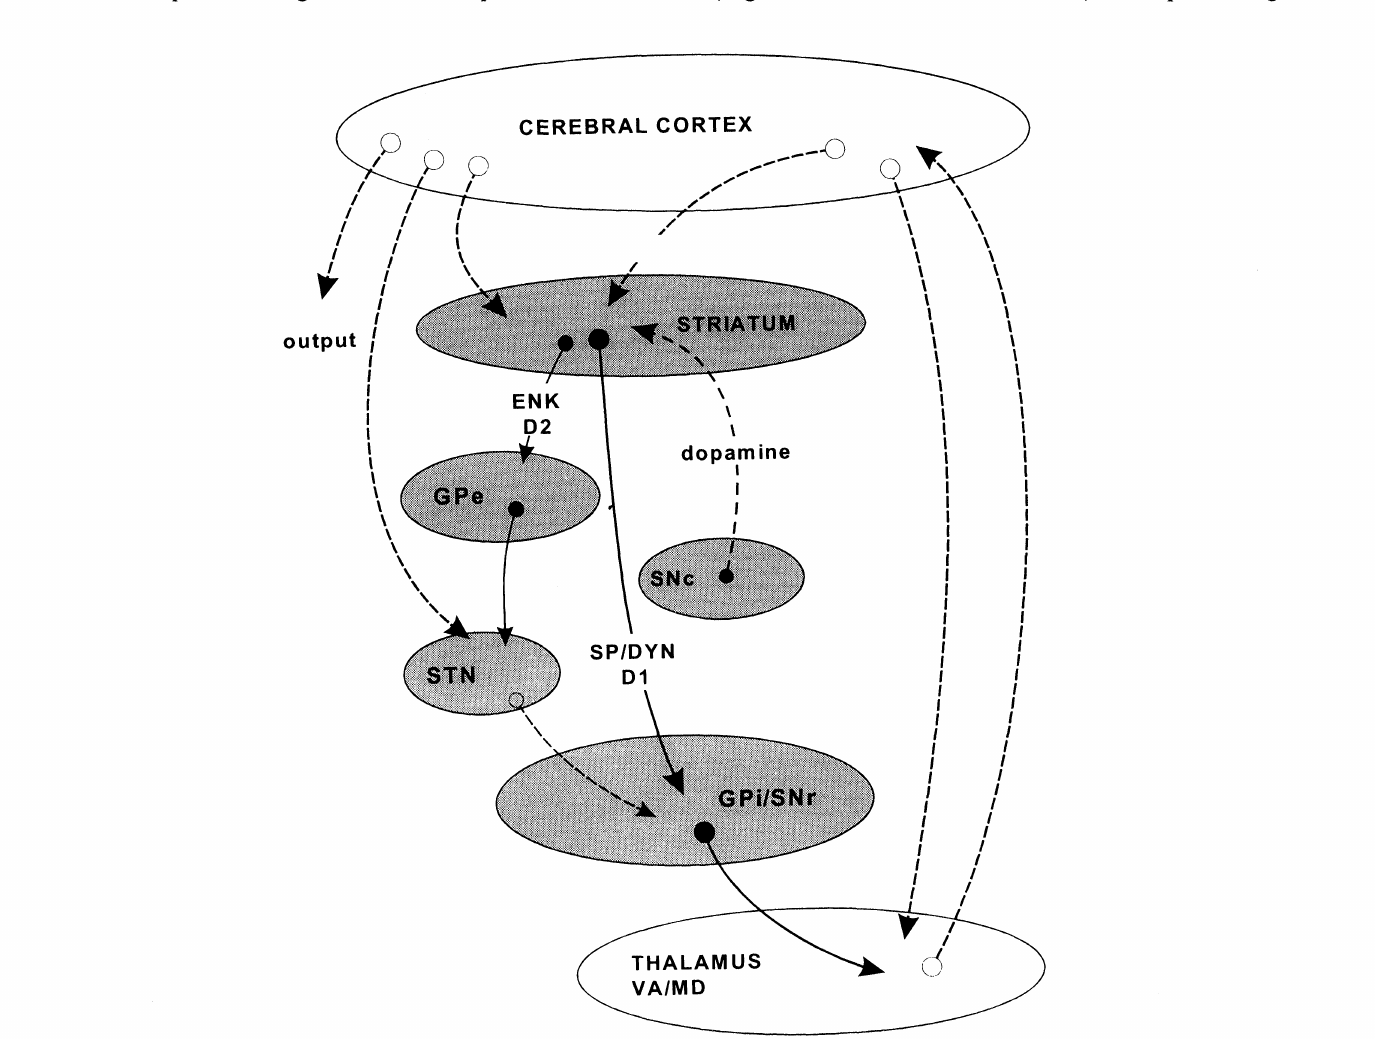
Fig. 2: Schematic representation of the organization of basal ganglia-thalamocortical circuits. Direct and indirect pathways between the striatum and the internal segment of the globus pallidus (GPi) and the substantia nigra pars reticulata (SNr) are outlined. In the direct pathway the peptides substance P (SP) and dynorphin (DYN) are expressed, together with the dopamine D receptor. In the indirect pathway, the projection from the striatum to the external segment of the globus pallidus (GPe) contains the peptide enkephalin (ENK) and the dopamine D2 receptor. This indirect pathway is further constituted by the GABAergic projection from GPe to the subthalamic nucleus (STN) and the glutamatergic STN projections to GPi/SNr. In the thalamus the ventral anterior (VA) and mediodorsal (MD) nuclei are reached by the basal ganglia outputs. Solid lines representing projections code for GABAergic pathways, dashed lines for glutamatergic pathways, unless otherwise